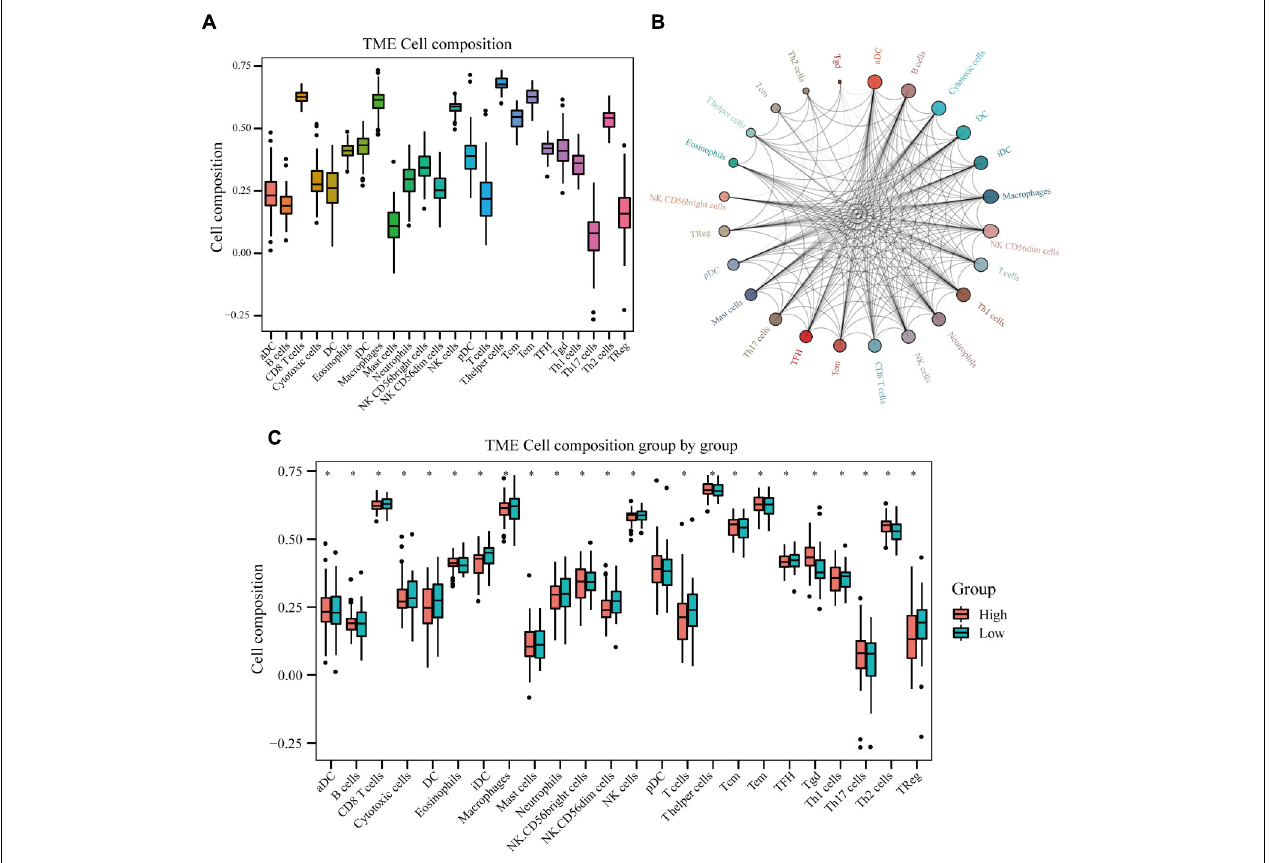
FIGURE 10 | Immune cell infiltration in osteosarcoma tissues of high- and low-risk patients. (A) Results of immune cell infiltration composition analyses. (B) Immune cell interaction network. (C) Differences in immune cell infiltration between high- and low-risk osteosarcoma